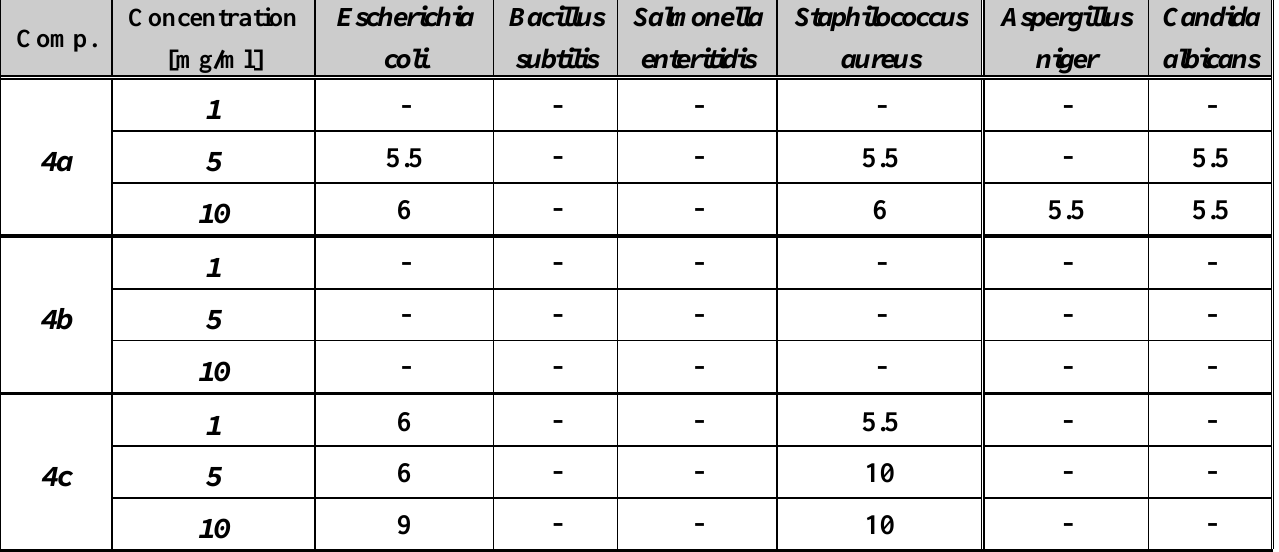
Table 2 : Inhibition zones